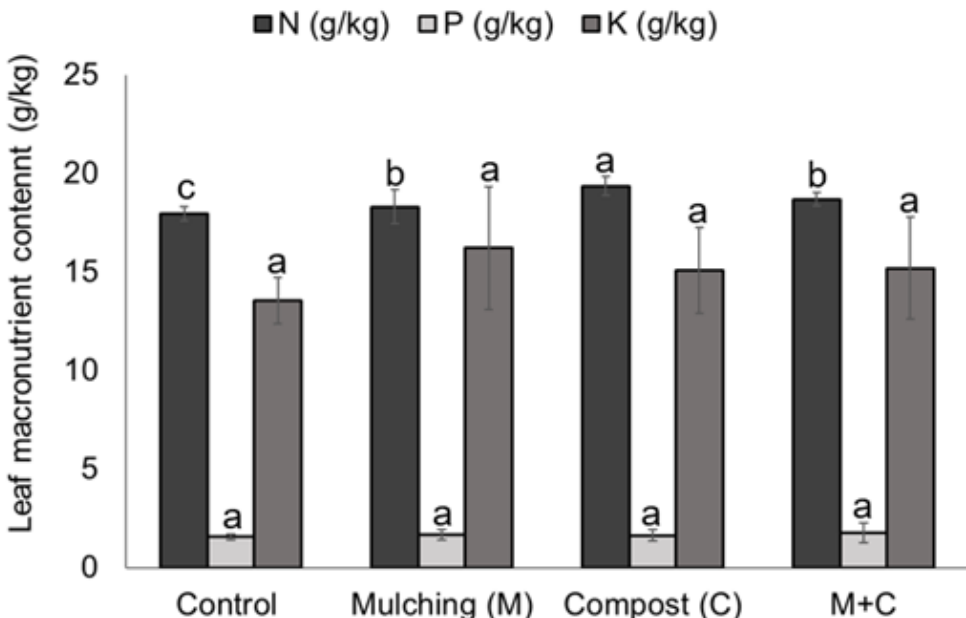
Figure 3. Leave macronutrient contents (N, P and K g kg − 1 ) among the studied treatments of organic residues management in a subtropical ecosystem, Curitibanos, Santa Catarina, Southern Brazil. Different small letters into each line differ by Bonferroni’s test ( p < 0.05). Mean values (n = 144) followed by the standard deviation in parenthesis.